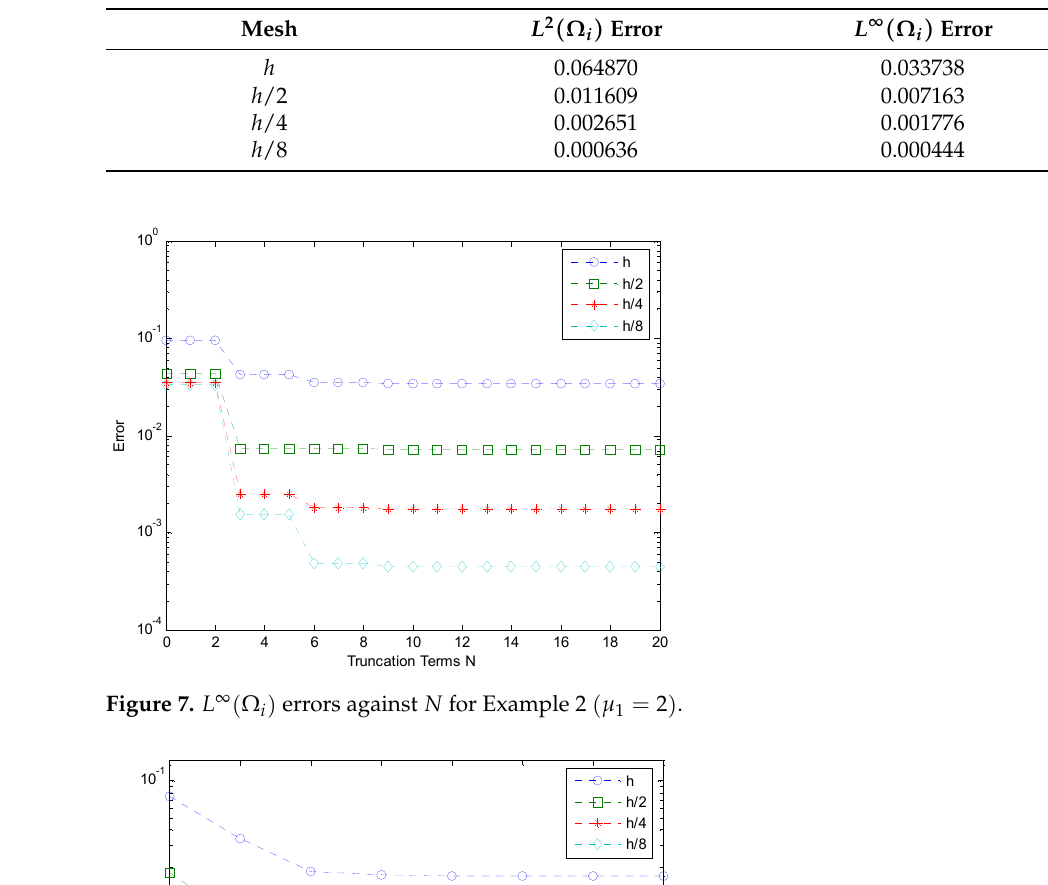
Table 2. The errors against mesh for Example 2 ( µ 1 = 2, N = 20 ) .